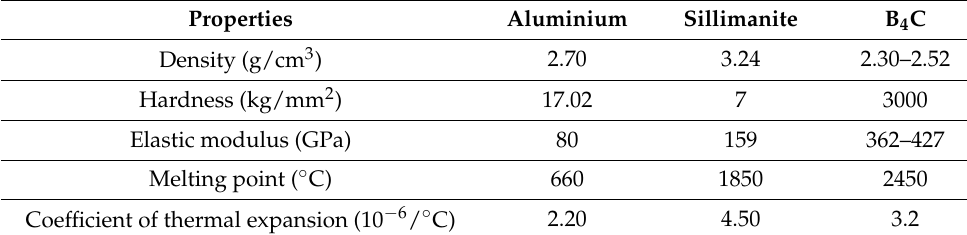
Table 2. Properties of aluminium, sillimanite and B 4 C.